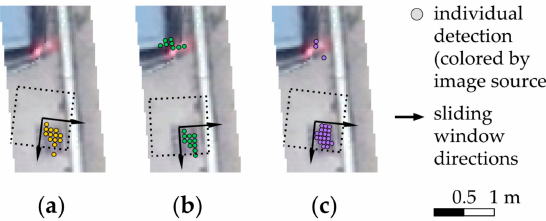
Figure 3. ( a – c ) Results of the moving window classification for 3 of 10 unmanned aerial vehicle (UAV) images in which the sewer inlet was detected. The points represent individual detections as the moving window moved across the original image, with the orientation of the detections reflecting the images’ orientation. The outline of the sliding window (square with dotted border) is to